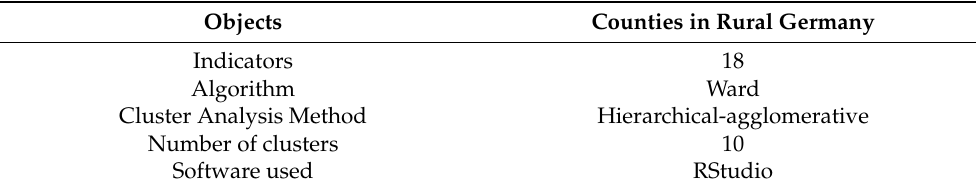
Table 5. Cluster